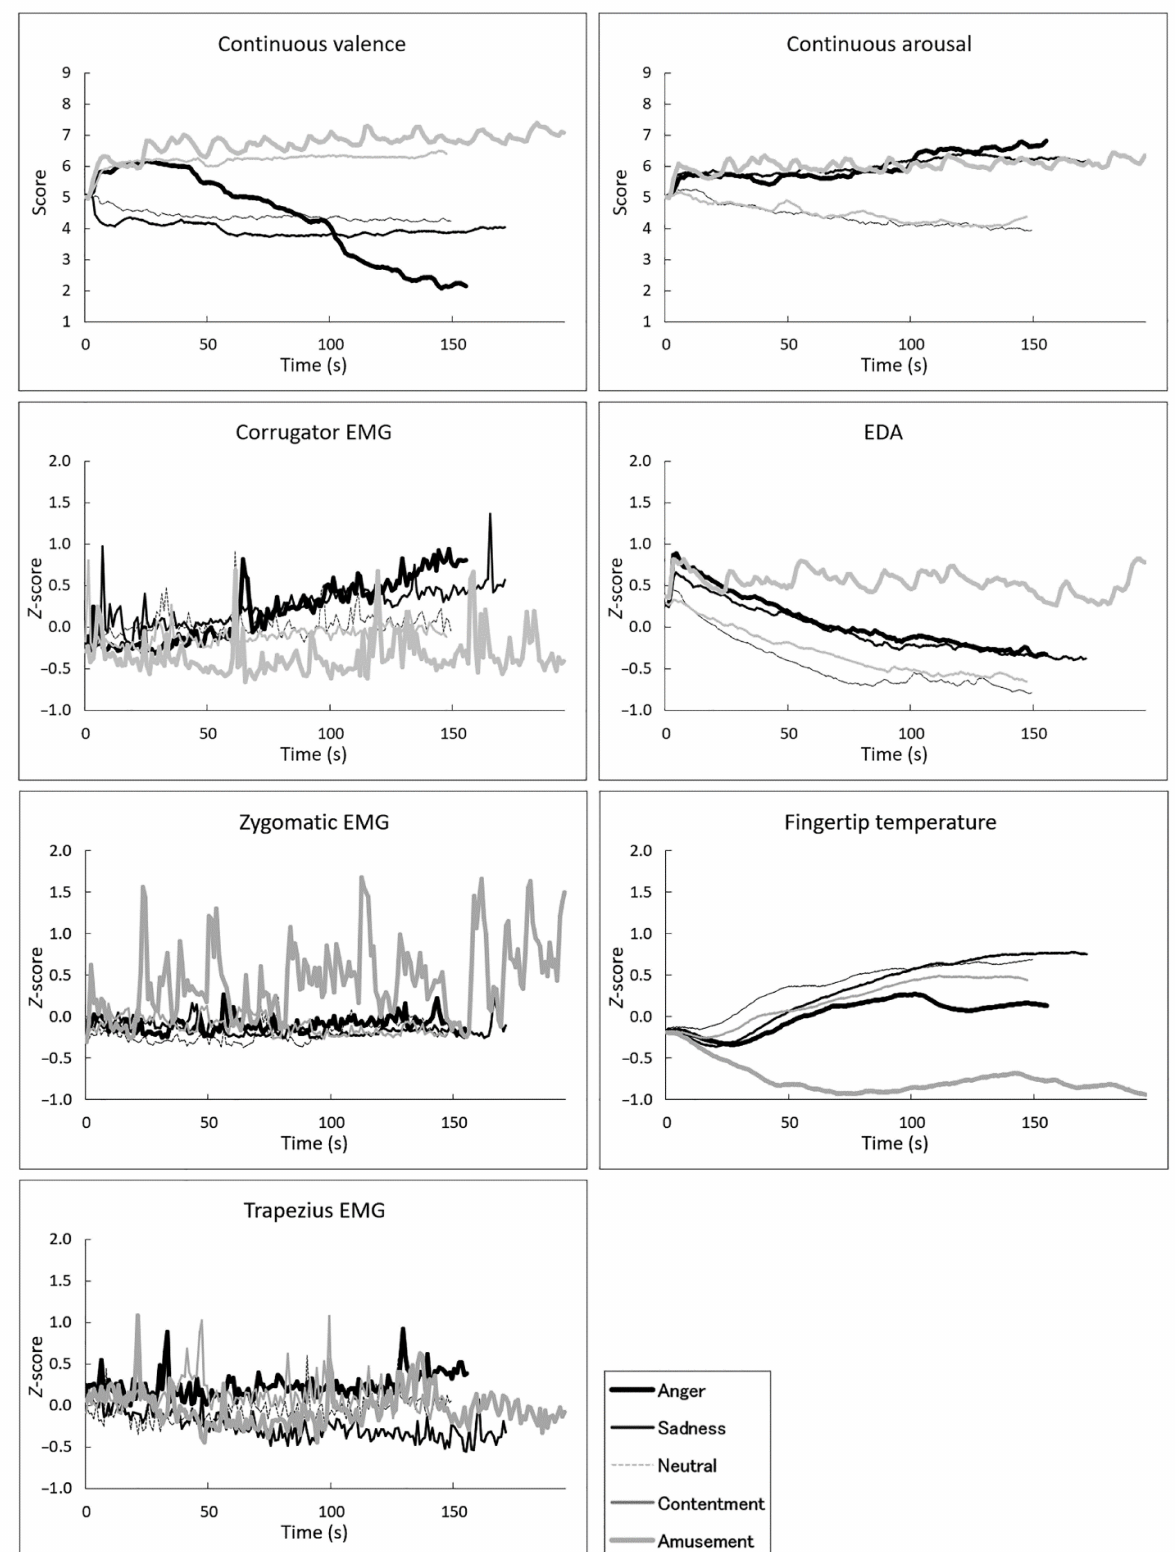
Figure 2. Group-mean continuous subjective ratings of valence and arousal, electromyography (EMG) recorded from the corrugator supercilii, zygomatic major, and trapezius muscles, electro- dermal activity (EDA), and fingertip temperature, over time. Physiological data were standardized within